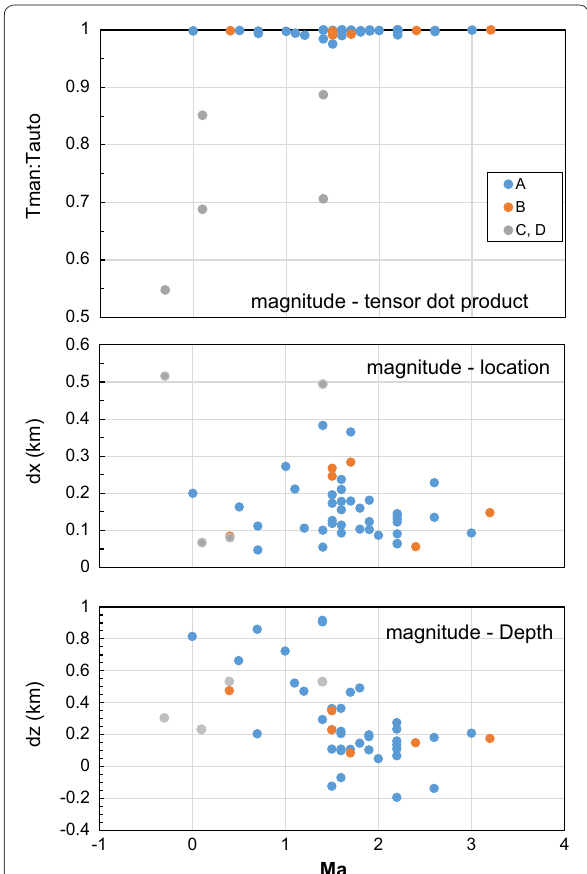
Fig. 3 Results of the reliability test for the auto-picking processing for various magnitude ranges. Manually picked phases and polarity data were used as a reference. Top) Tensor product showing the discrepancies between tensors by the auto-picking and reference focal mechanisms. Middle) Location differences in horizontal and Bottom) depth directions. The symbol colors indicate the quality of the focal mechanism data for the reference event using the HASH